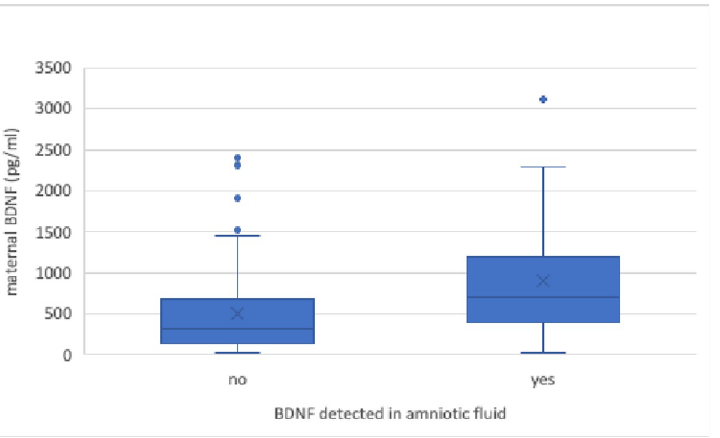
Fig 1. Maternal Blood BDNF concentration (pg/ml) in cases with and without detectable AF- BDNF (group A and B). In specimens of group A, BMI before pregnancy was significantly higher (mean ± SD 23.8 ± 4.5 (kg/m 2 ) vs. mean ± SD 26.3 ± 6.7 (kg/m 2 ); p = 0.042), with a significant correlation between maternal BMI before pregnancy and maternal BDNF concentrations (r = -0.25; p = 0.01). “ S3 Fig” .No significant difference was seen comparing maternal, fetal an AF-BDNF between obese (BMI � 30 kg/m 2 ) and non-obese (BMI < 30 kg/m 2 ) patients (maternal BDNF p = 0.06, fetal BDNF p = 0.08, AF-BDNF p = 0.08). No difference was found between group A and B regarding maternal age, smoking status, maternal platelet count, GA, indication for amniocentesis, abnormal karyotype, fetal anomalies, ultrasound estimation of AF volume, twin rates and chorionicity, AF-TP concentration, and time interval between sample collection and centrifugation “Table 1”